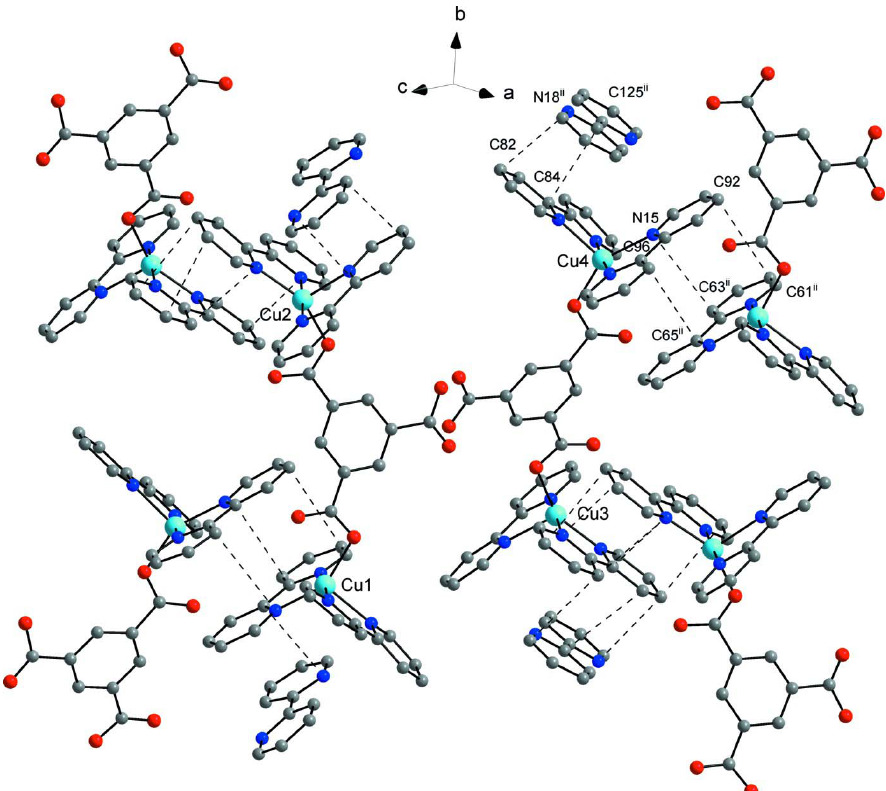
Figure 3 Part of the crystal structure showing the formation of π - π stacking interactions of the C···C ii and C···N ii type connecting free and coordinated bpy molecules [C84···C125 ii = 3.544 (5) Å, C92···C61 ii = 3.563 (5) Å, C96···C65 ii = 3.425 (5) Å, C82···N18 ii = 3.526 (6) Å and N15···C63 ii = 3.510 (4) Å. Symmetry code: (ii) - x + 1, y + 1/2, - z ]. The water molecules and Hbtc anions of crystallization have been omitted for